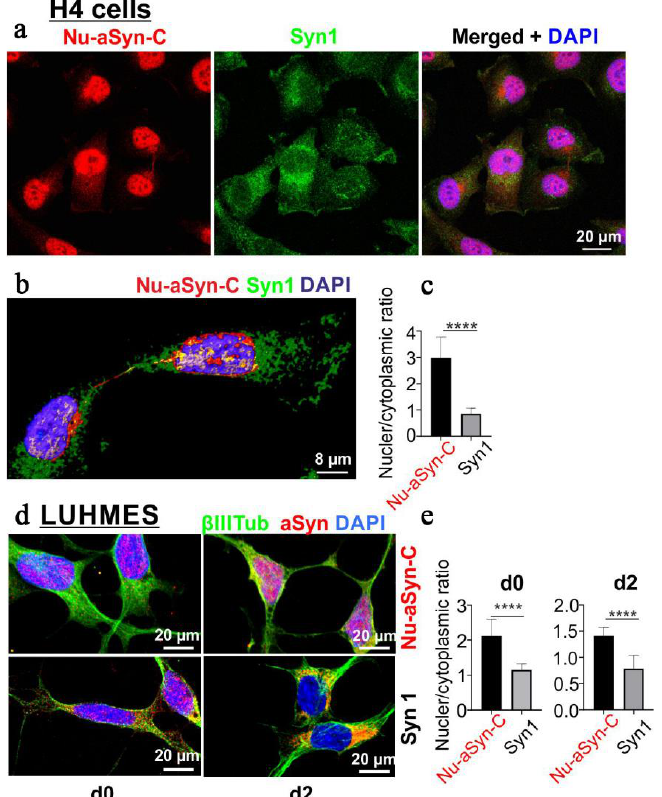
Figure 2. Labelling of aSyn with Nu-aSyn-C and Syn1 antibodies in proliferating H4 and LUHMES cells (d0), as well as in LUHMES cells after 2 days of differentiation. Nu-aSyn-C immunosignals are predominantly present in the nucleus, whereas Syn1 immunosignals are detected to a larger extent in the cytosol. ( a ) ICC analysis of aSyn distribution in H4 cells detected by Nu-aSyn-C and Syn1 antibodies. ( b ) A 3D reconstruction of representative proliferating H4 cells. ( c ) Ratio of nuclear versus cytoplasmic immunosignal intensity detected by Nu-aSyn-C and Syn1 antibodies, respectively. Data represent the mean ± SD from 35 cells for each antibody. Statistics: Mann–Whitney test; **** p < 0.001. ( d ) aSyn distribution patterns recognized by Nu-aSyn-C and Syn1 antibodies, respectively, in proliferating (d0) and differentiating LUHMES cells (d2). ( e ) Quantification of the ratios of nuclear and cytoplasmic immunosignal intensity. Data represent the mean ± SD from 11–21 cells for each antibody. Statistics: Mann–Whitney test; **** p < 0.001. To verify the distinct distribution patterns detected by ICC with Nu-aSyn-C and Syn1 antibodies, we enriched nuclear and cytoplasmic fractions from H4 cells by biochemical fractionations followed by native dot blot and denaturing SDS-PAGE/WB analyses. In line with the ICC results, dot blot and WB analyses both confirmed a higher affinity of the Nu-aSyn-C antibody to nuclear aSyn, as compared to cytosolic aSyn (dot blot, Figure 3a; WB, Figure S2a). Interestingly, WB analysis using the Nu-aSyn-C antibody detected not only aSyn monomers but also abundant high-molecular-weight immunopositive species